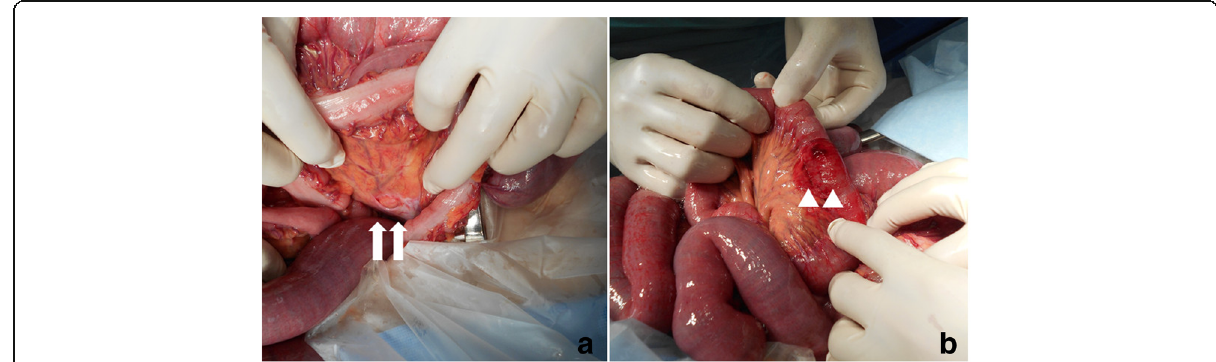
Fig. 2 a Laparotomy showing a sigmoid mesocolon defect (white arrows). b Approximately 100 cm of the small intestine extending from the ligament of Treitz is seen to have herniated into the defect of sigmoid mesocolon (Richter-type hernia), although the incarcerated portion of the small intestine is observed to be viable (white arrowheads)